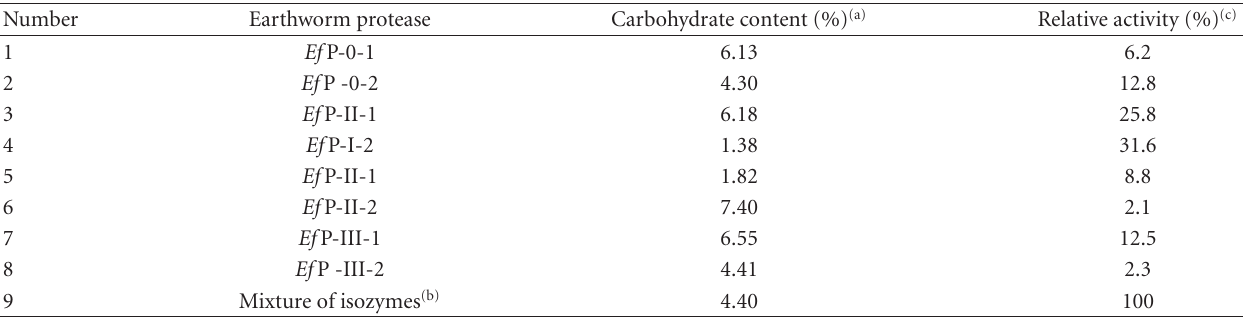
Table 4: The Carbohydrate content of the eight isozymes.